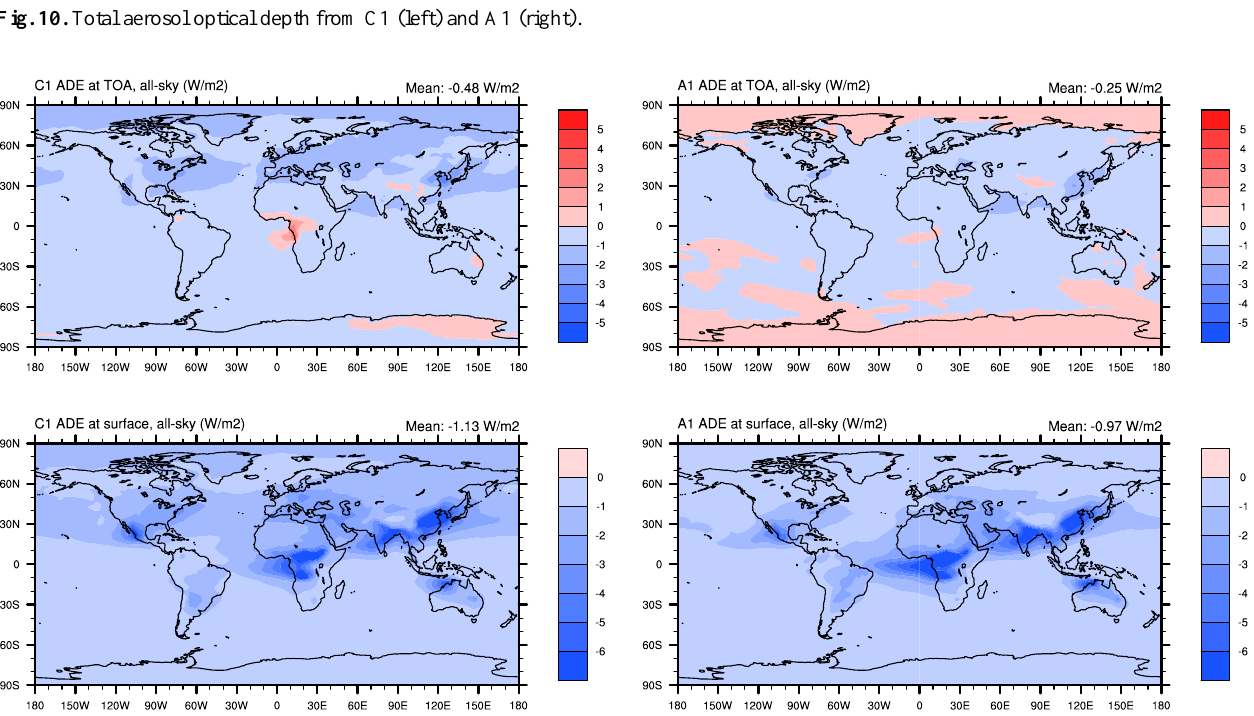
Fig. 11. All-sky direct effect at the TOA (top) and surface (bottom) in C1 (left) and A1 (right).